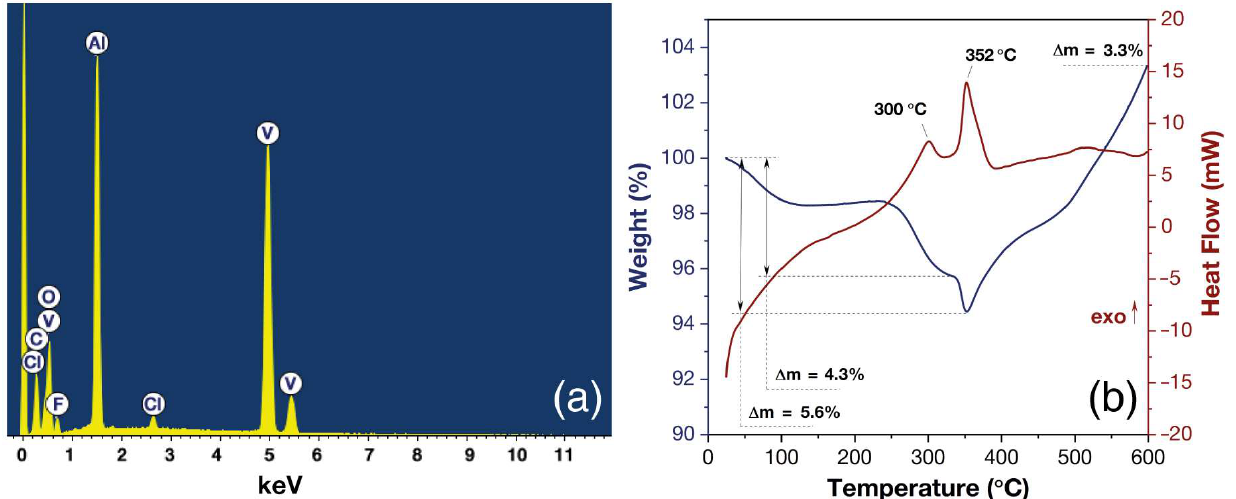
Figure 4. EDX spectrum of V 2 CT X film on Al 2 O 3 substrate ( a ) and DSC (red) and TGA (blue) curves of the obtained V 2 CT x powder during heating in an air current ( b ).